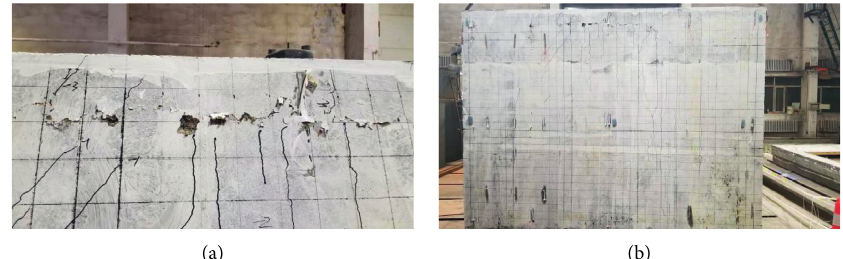
Figure 14: The experimental phenomena: (a) the damage of interwall top beam; (b) the cracks in the inner